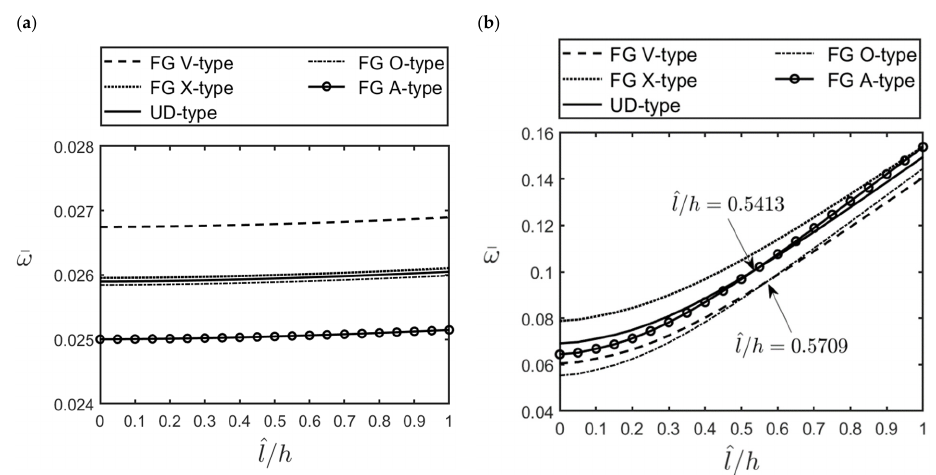
Figure 4. Variations in the lowest dimensionless natural frequencies of an FG-GPLRC thin cylindri- ( ) ˆ ˆ, m n , for which R / h = 20, L / R = 5, ˆ / 1.0 l h = cal microshell with the wave number pairs 0.01 W = , and for the cases of ( a ) FG V-type, ( b ) FG X-type, ( c ) UD, ( d ) FG O-type, ( e ) FG A-type GPL GPL distribution pa tt erns, and ( f ) homogeneous epoxy.